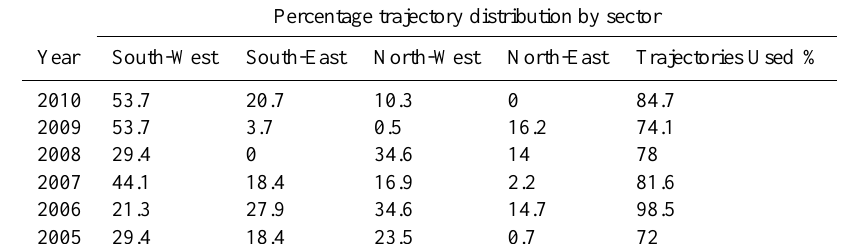
Table 3. The percentage distribution within the sectors (NW, SW, SE, NE) are shown for the years 2005–2010. Percentage trajectory distribution by sector